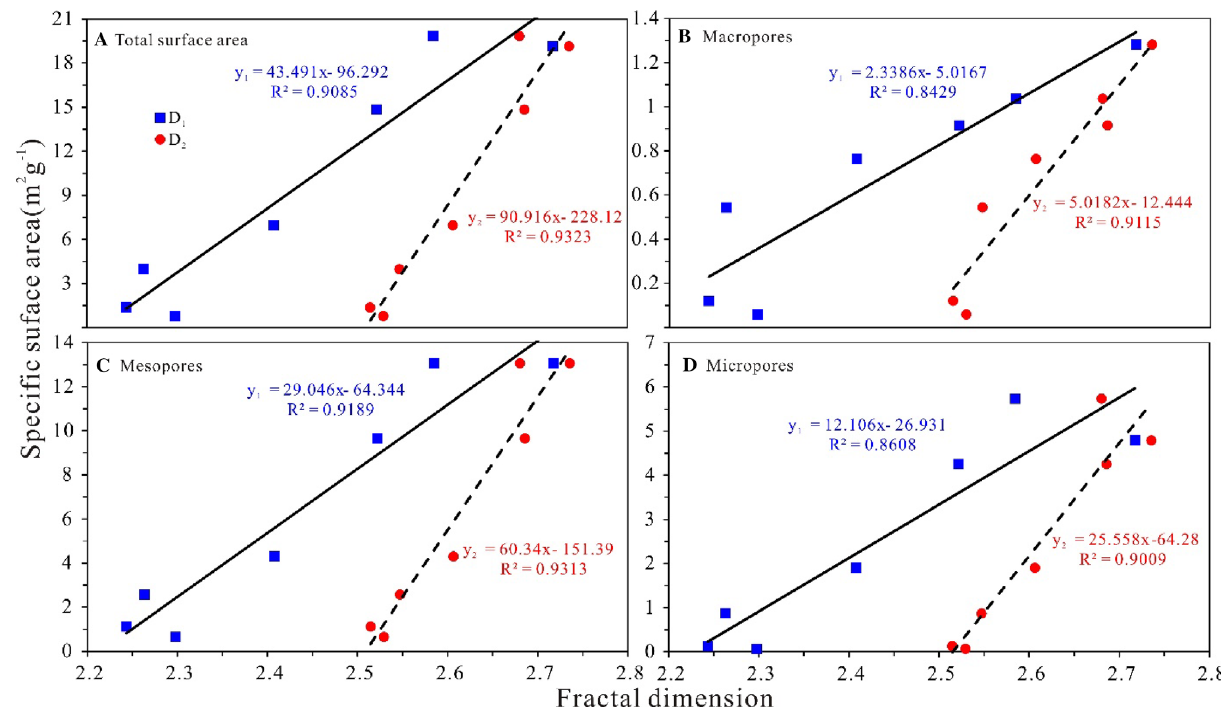
Fig. 6 Relationships between fractal dimensions and pore specific surface areas in pyrolyzed oil